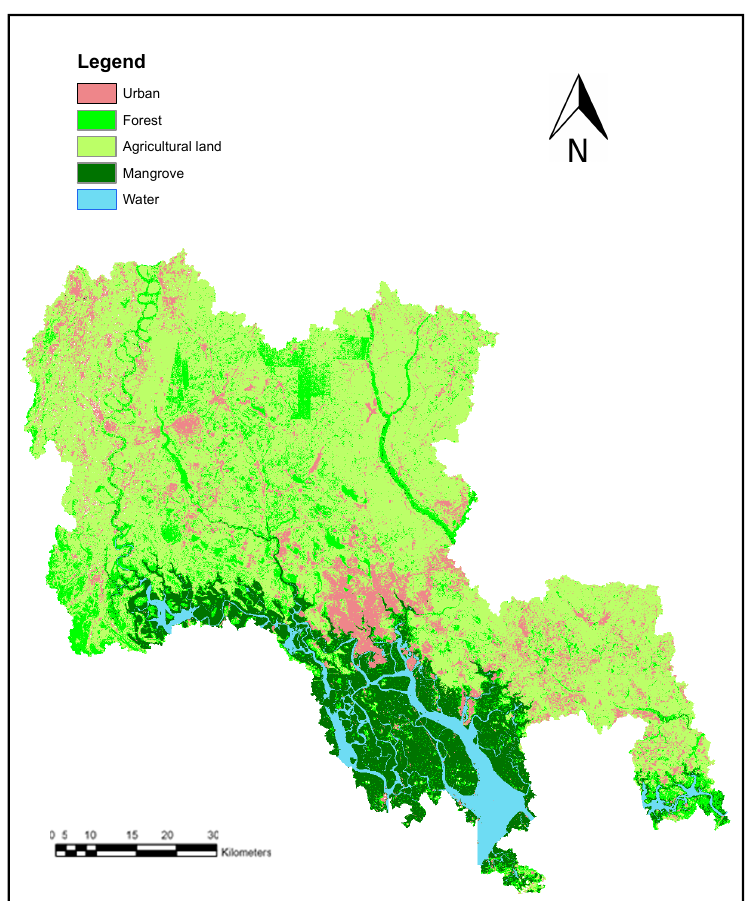
Figure 5. Map showing the classified LULC map of Greater Port Harcourt watershed for 2003. LULC classes include Urban Area, Forest, Agricultural Land, Mangrove, and Water.